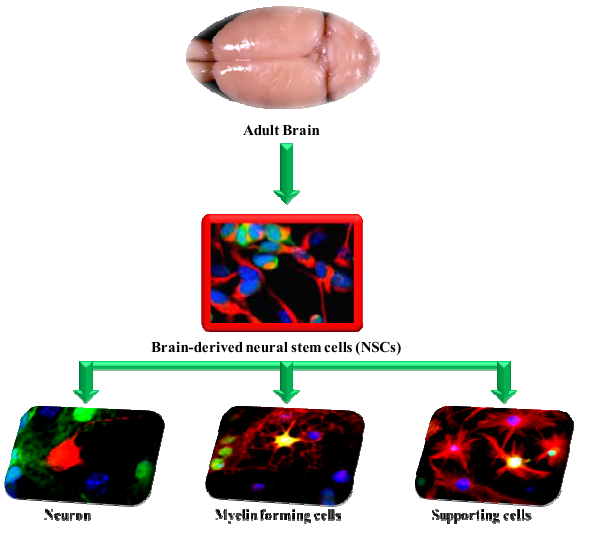
Figure 4. Depiction of adult neural stem demonstrating their intrinsic potential to generate cell types of the brain and spinal cord (Adapted from: Karimi and Eftekharpour, Fehlings lab, McEwan Centre for Regnerative